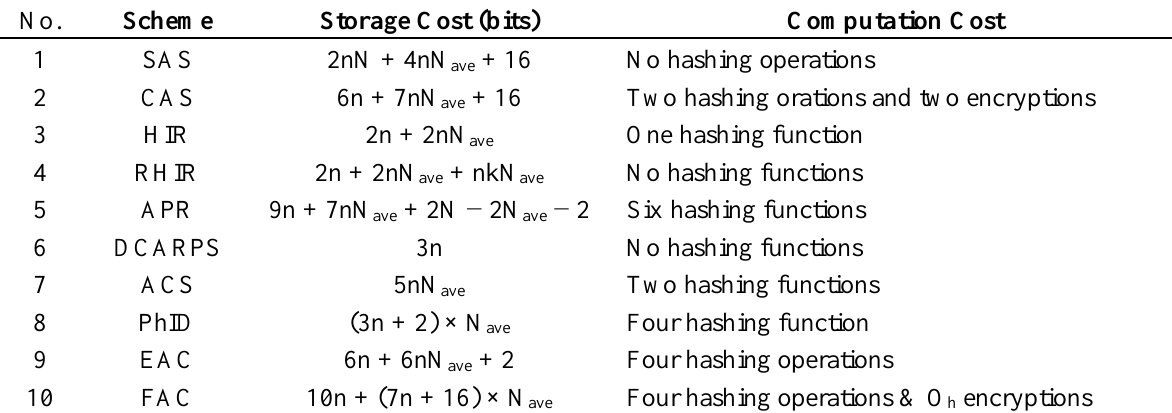
Table 4. Performance Comparison. N is the total number of sensors; N ave is the average number of neighbors; k (only for RHIR) is number of stored hash values where the SN stores k hash values per one neighbor which are calculated in advance at setup